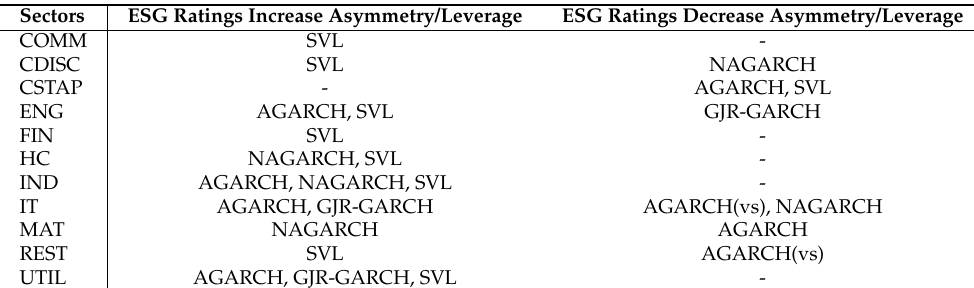
Table 8. Summary of results by sector for the AB-GLS